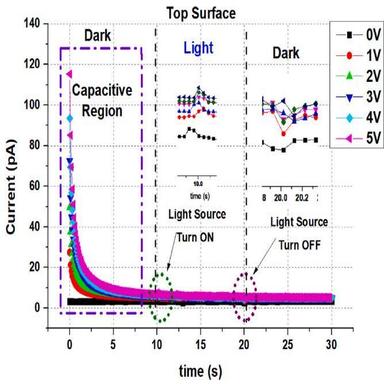
Kinetics of Current under photovoltaic Dark and luminous condition of AlN stack.